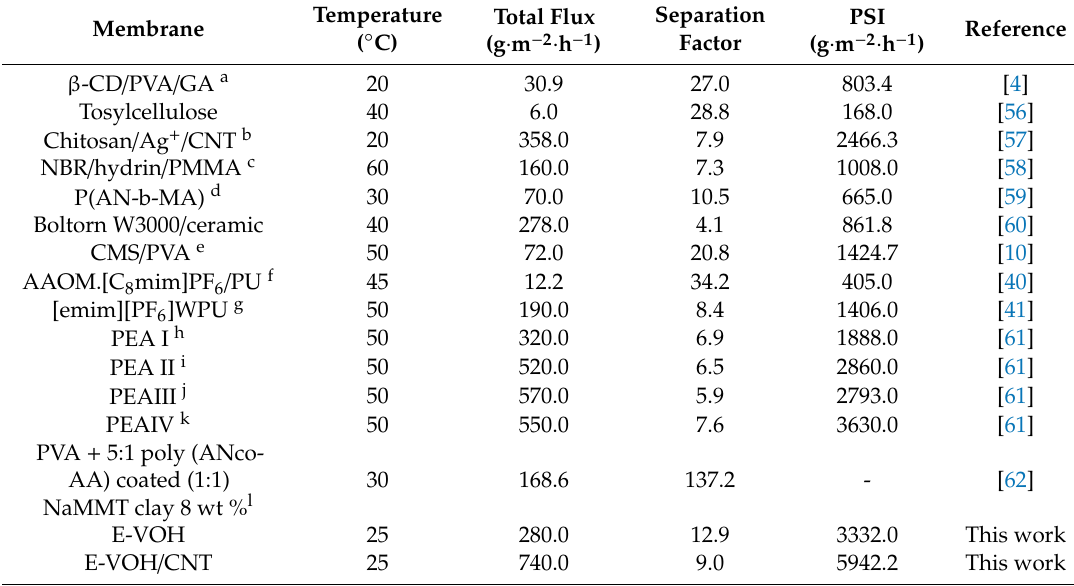
Table 8. Comparative values of the total flux and separation factor for equal-ratio benzene / cyclohexane mixture separation by pervaporation techniques using di ff erent